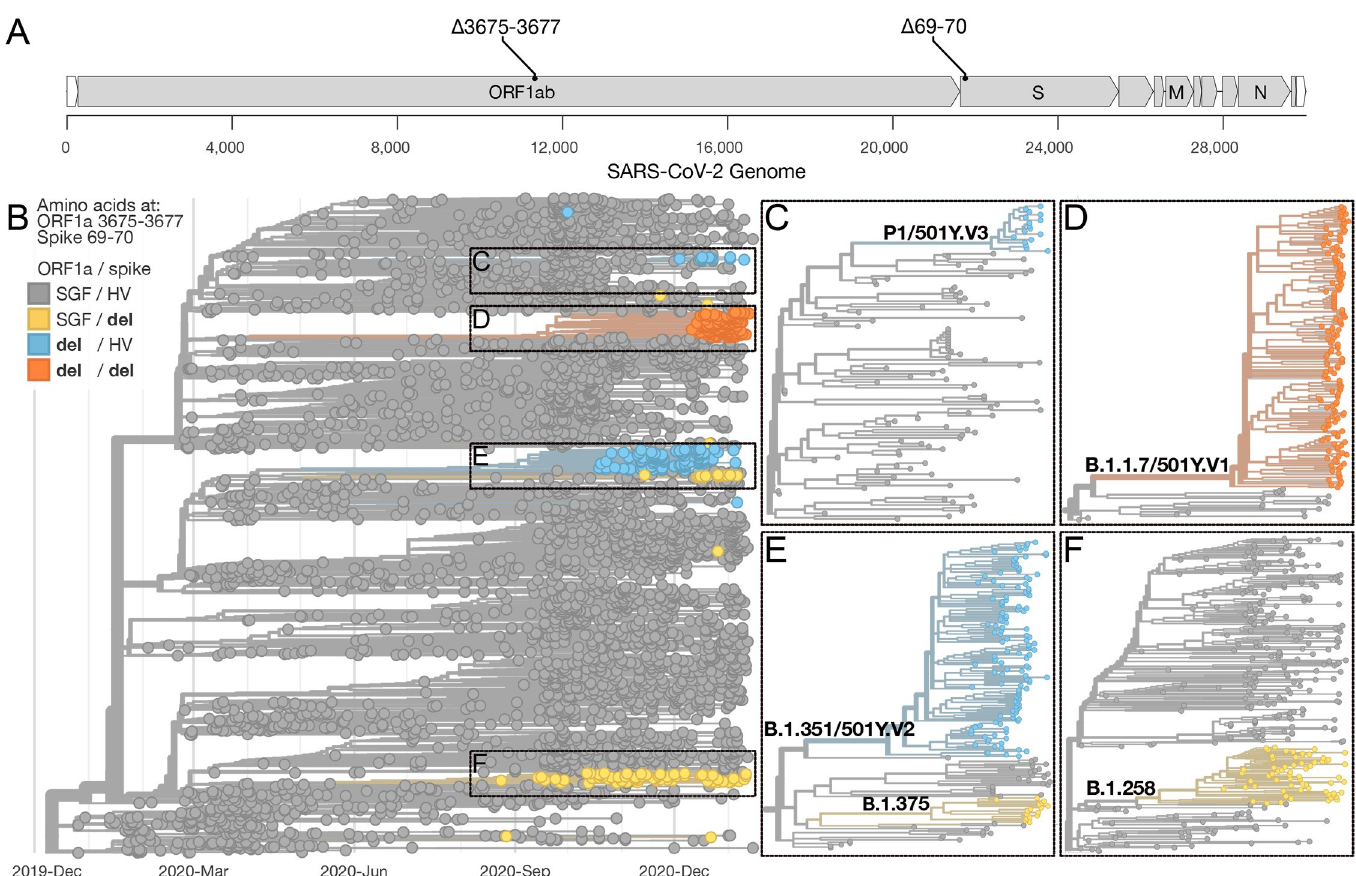
Fig 1. Identification of genome targets to differentiate between B.1.1.7, B.1.351, P.1, and other SARS-CoV-2 lineages. ( A ) Location on the SARS-CoV-2 genome where the targeted deletions in the ORF1a gene at amino acid positions 3675–3677 ( Δ 3675–3677) and the spike gene at amino acid positions 69–70 ( Δ 69–70) occur. ( B